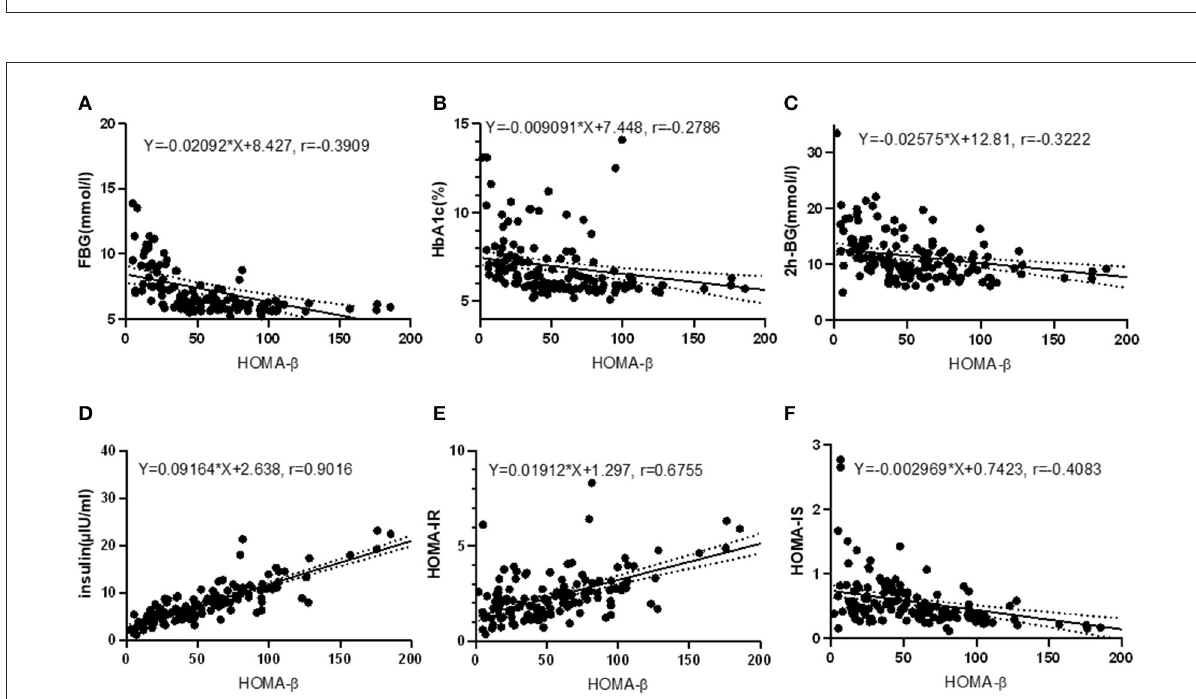
FIGURE3 Correlations between HOMA- β and glucose homeostasis indexes. (A) correlation between HOMA- β and FBG ( R 2 = 0.1528, F = 25.25, P < 0.001); (B) correlation between HOMA- β and HbA1c ( R 2 = 0.0800, F = 11.78, P < 0.001); (C) correlation between HOMA- β and 2h-BG ( R 2 = 0.1038, F = 16.21, P < 0.001); (D) correlation between HOMA- β and insulin ( R 2 = 0.8128, F = 608.0, P < 0.001); (E) correlation between HOMA- β and HOMA-IR ( R 2 = 0.4563, F = 117.5, P < 0.001); (F) correlation between HOMA- β and HOMA-IS ( R 2 = 0.1667, F = 28.01, P <